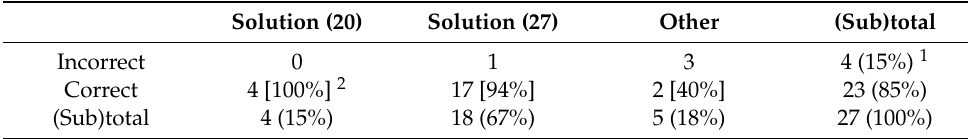
Table 3. Summary of solving the first-order linear ODE in the assignment in